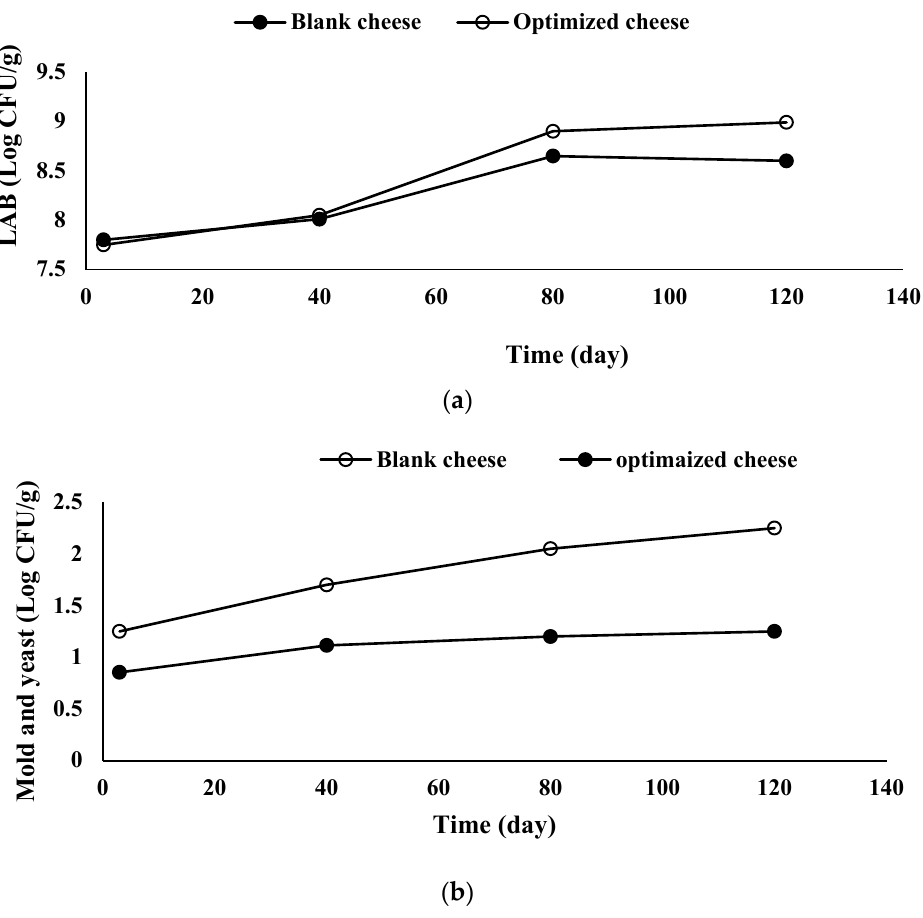
Figure 6. Total LAB counts ( a ) and the mold and yeast populations ( b ) of SBL-extract-added Feta- cheese ( ● ) and control cheese ( ○ ) during 120 days of storage time.